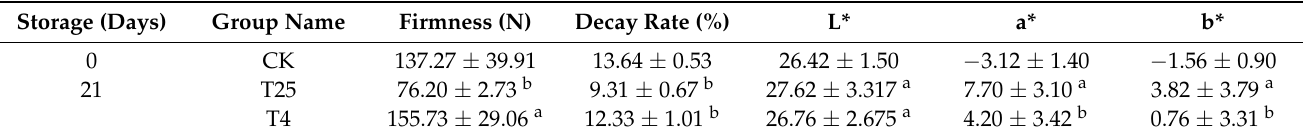
Table 3. Preservation quality indices of blueberry samples at different storage temperatures.